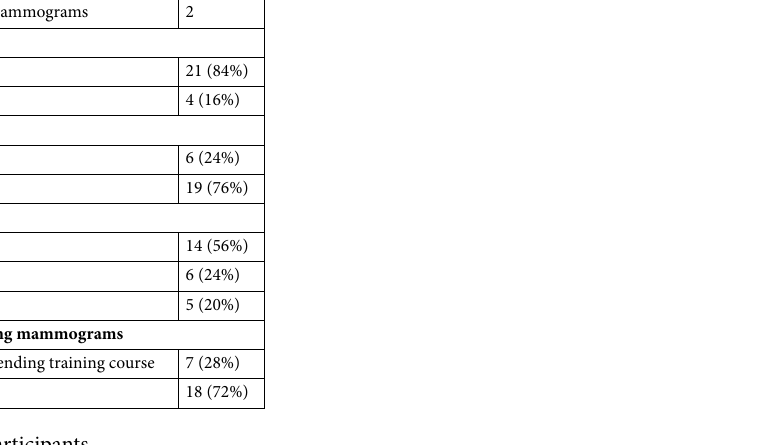
Table 3. Details of